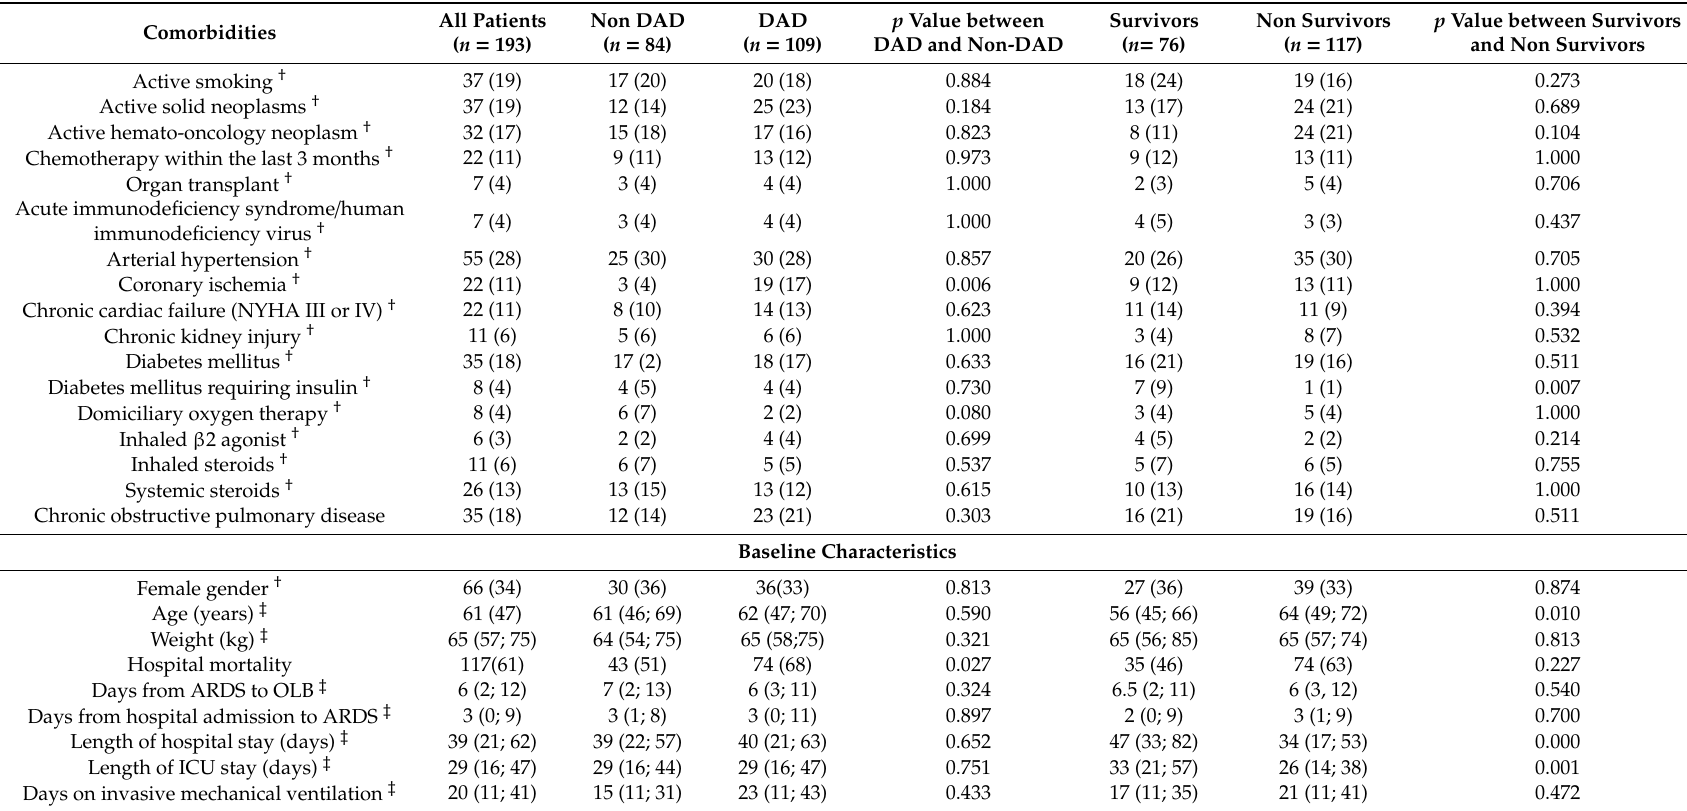
Table 3. Bivariate analysis of comorbidities and baseline characteristics for DAD and hospital